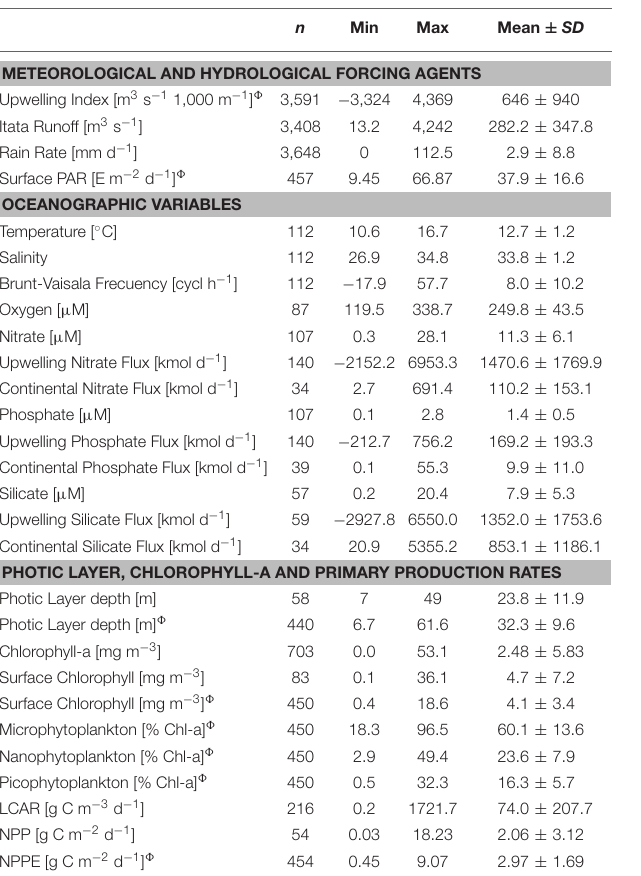
TABLE 2 | Summary of statistics values, i.e., number of samples (n), Minimum (Min), Maximum (Max), Mean and Standard Deviation (SD) for variables analyzed in annual cycles section. In situ mean values were calculated for the upper 10m of the water column.